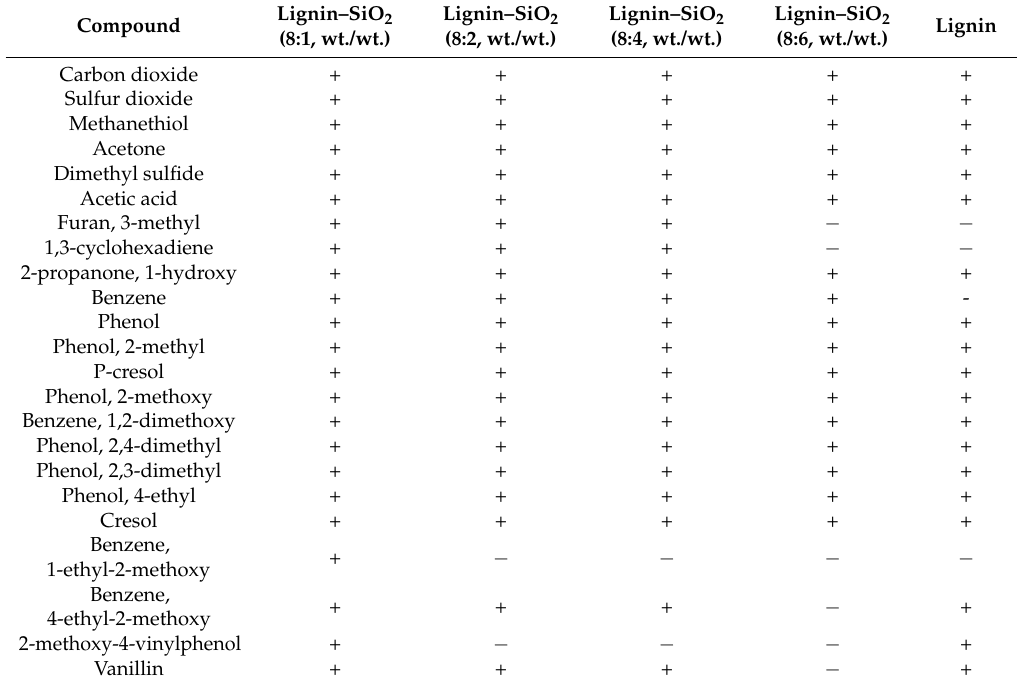
Table 3. Compounds detected in TG-MS analysis for lignin–silica hybrid fillers and pure lignin.